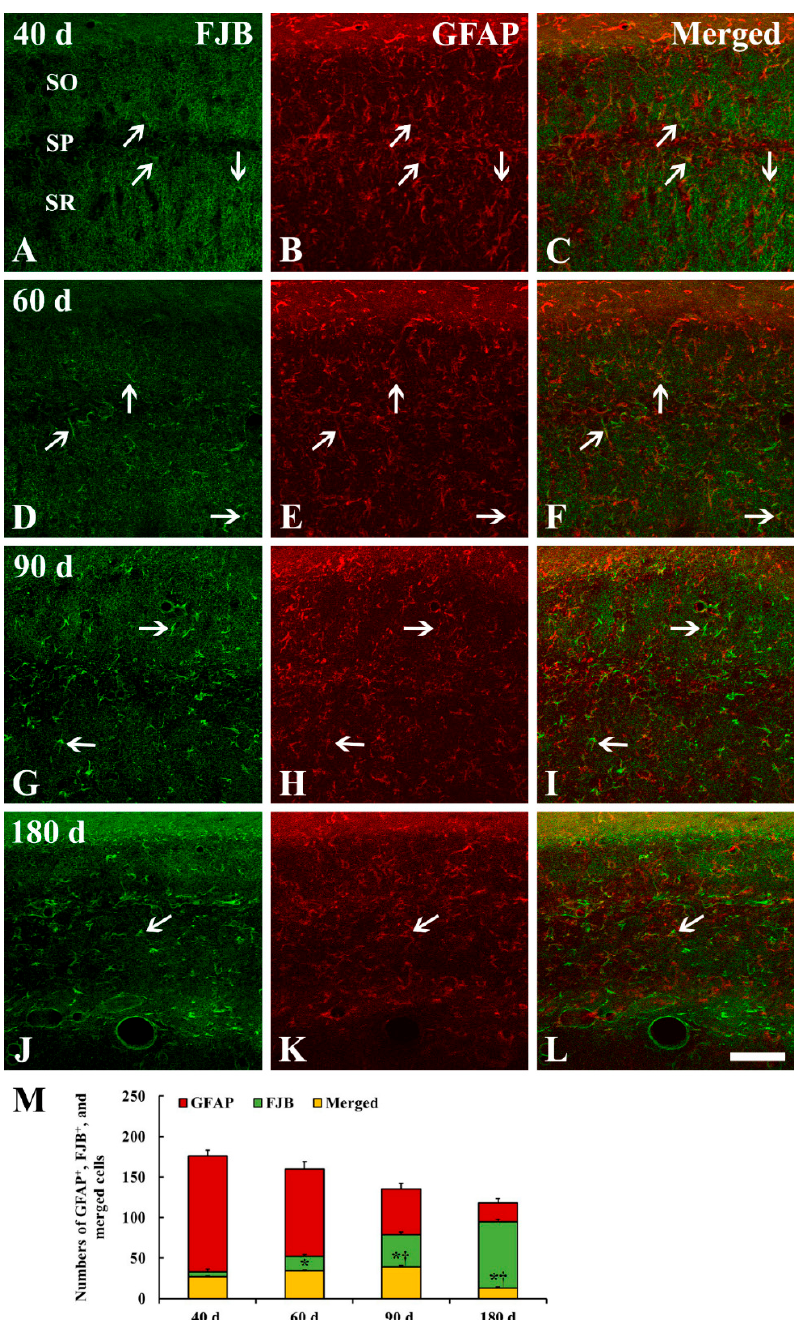
Figure 6. Double immunofluorescence staining for FJB ( A , D , G , J ), GFAP ( B , E , H , K ) and merged images ( C , F , I , L ) in the CA1 at 40 ( A – C ), 60 ( D – F ), 90 ( G – I ), and 180 ( J – L ) days after tgCI. The number of FJB + /GFAP + astrocytes (degenerating astrocytes, white arrows) is significantly increased until 90 days after tgCI. Thereafter, the number is gradually decreased. On the contrary, the number of FJB + cells (dead astrocytes) is gradually and significantly increased with time. Scale bar = 50 µ m. ( M ) Numbers of GFAP + , FJB + , and FJB + /GFAP + cells ( n = 7; * p < 0.05 vs. sham operated group, † p < 0.05 vs. pre-time point group). The bars indicate the means ± SEM.